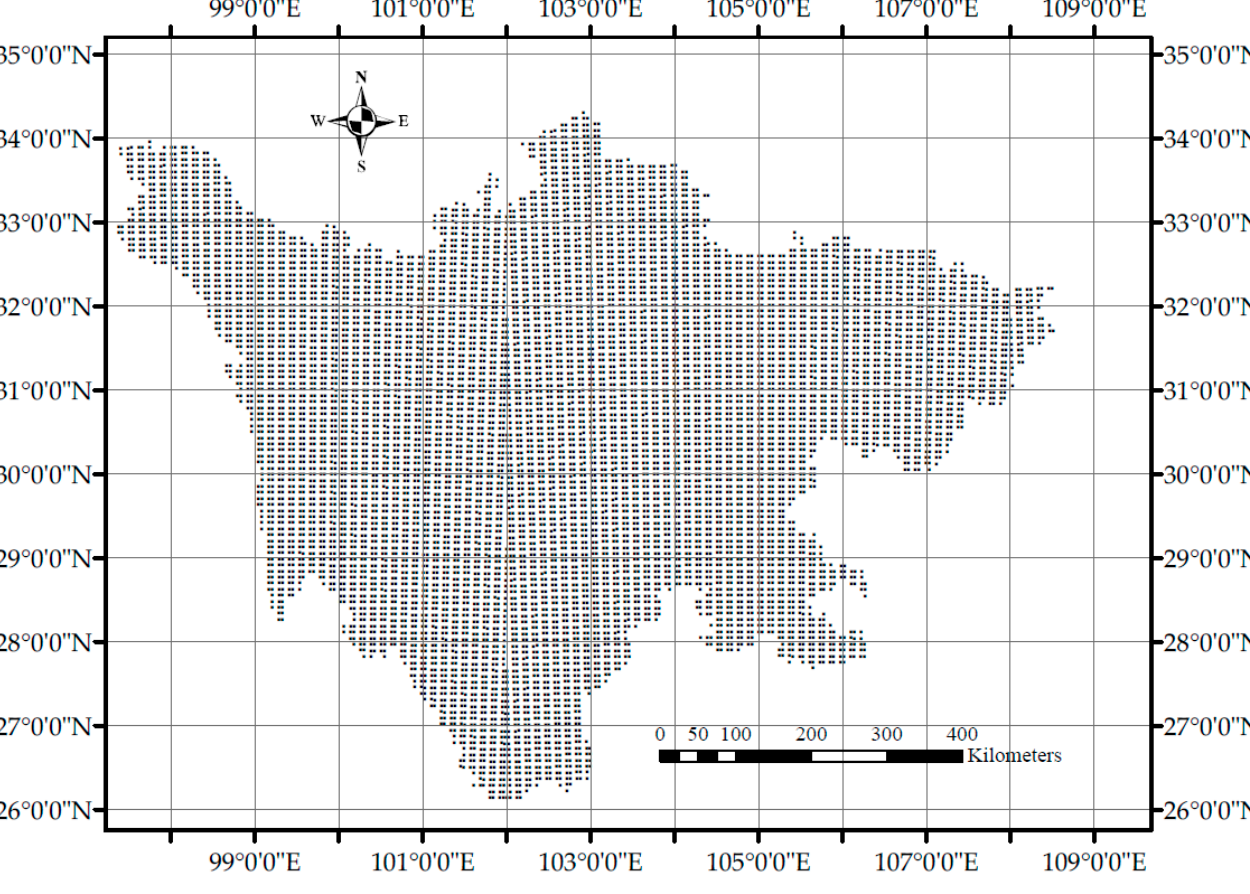
Figure 1. Schematic diagram of the plot layout in Sichuan Province.